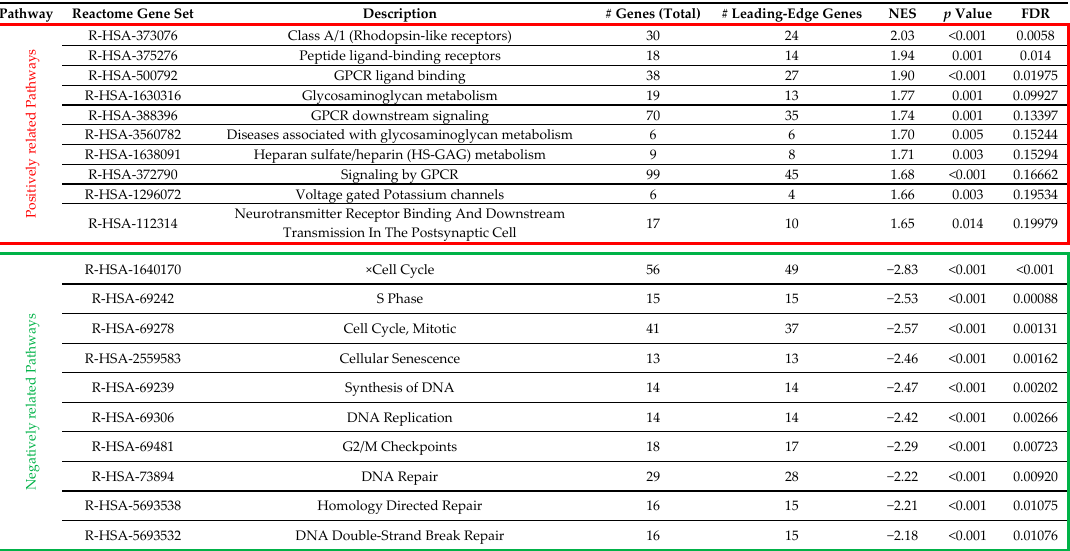
Table 2. Reactome gene set enrichment performed with WebGestalt.